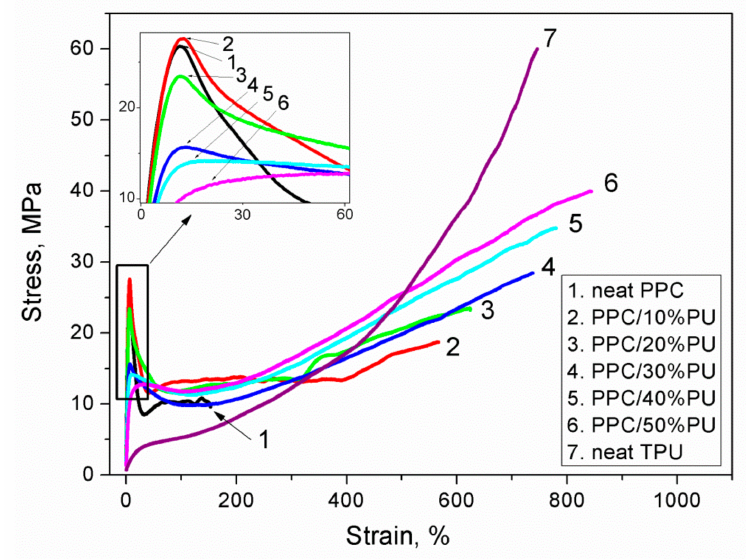
Figure 5. Stress-strain curves of PPC/TPU blends with different TPU